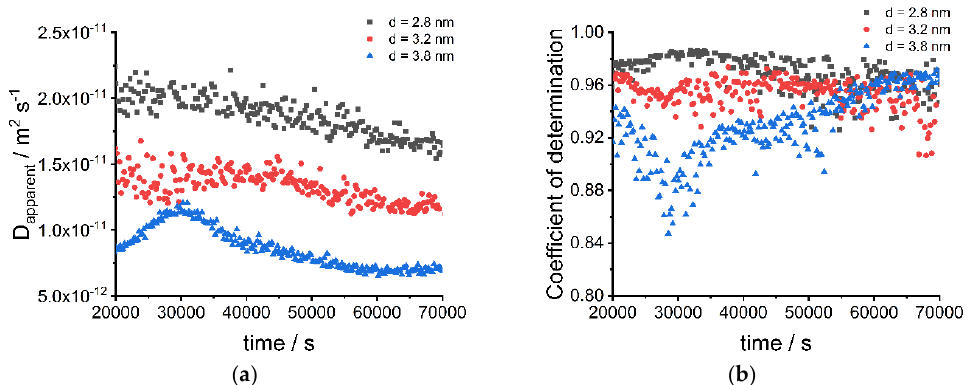
Figure 3. ( a ) Apparent diffusion coefficients of small (d = 2.8 nm), medium-sized (d = 3.2 nm) and large